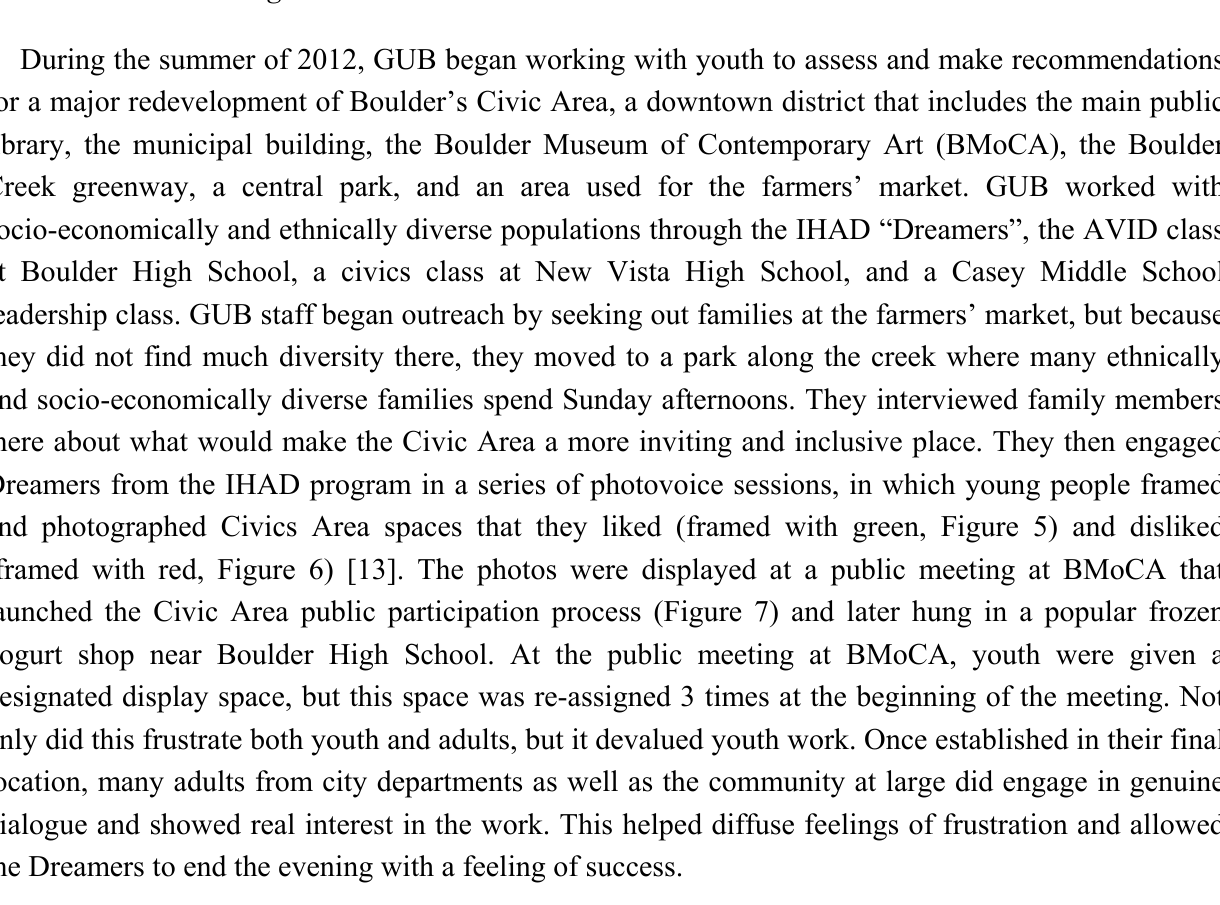
Figure 5. A “Dreamer” using photovoice to document positive public spaces in Boulder (photo courtesy of Brendan